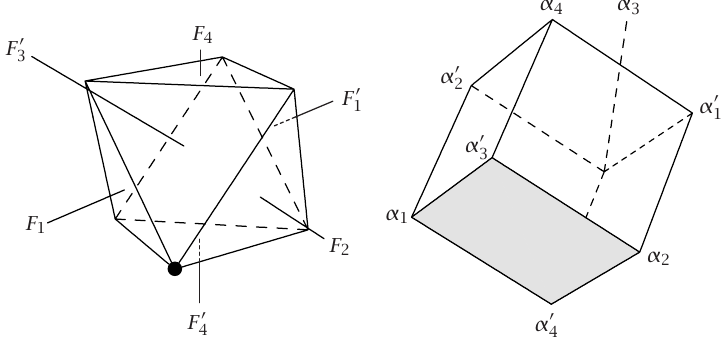
(cid:6) of octahedron are j , F j